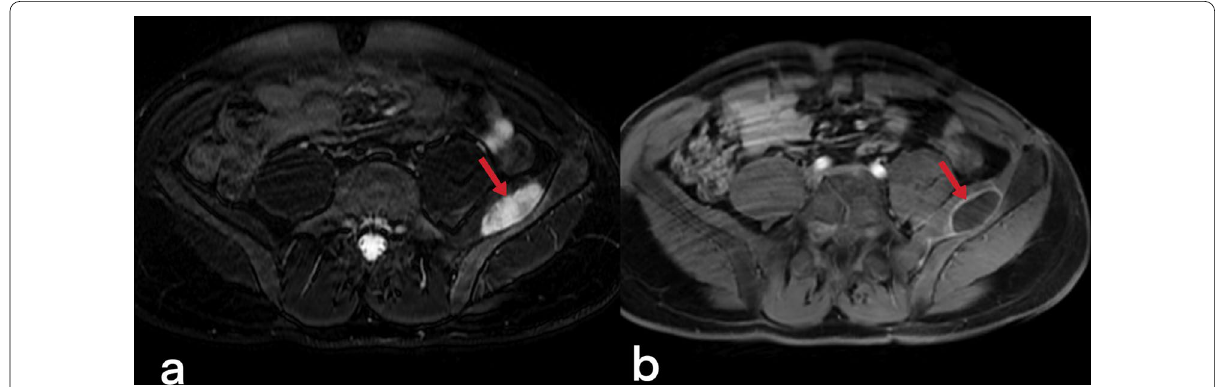
Fig. 56 T2 weighted ( a ) and post-contrast T1 weighted MR images of a 35-year-old male demonstrate abscess formation with peripheral enhancement in the left iliac muscle ( b